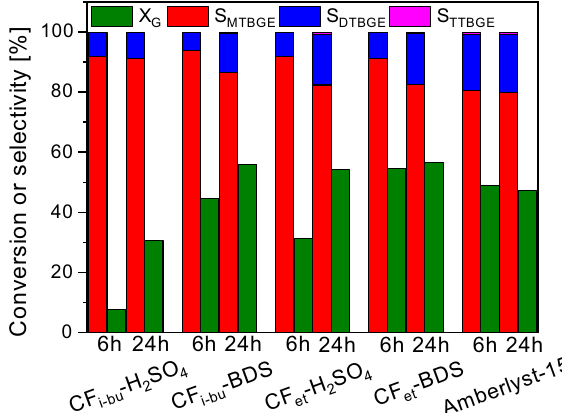
Figure 9. Glycerol conversions and selectivities to individual products after 6 and 24 h of the reaction using the prepared CFs and a commercial catalyst, Amberlyst-15.